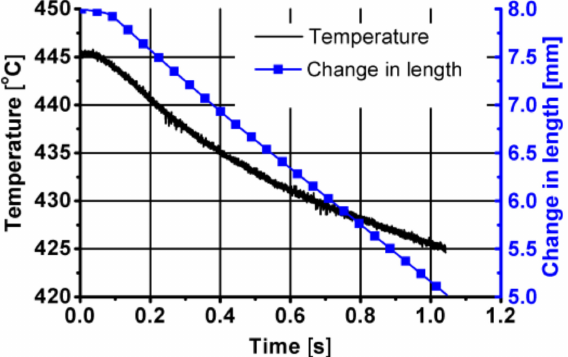
Figure 30. Temperature and length changes over time in the second stage of the friction welding of the 6XXX series